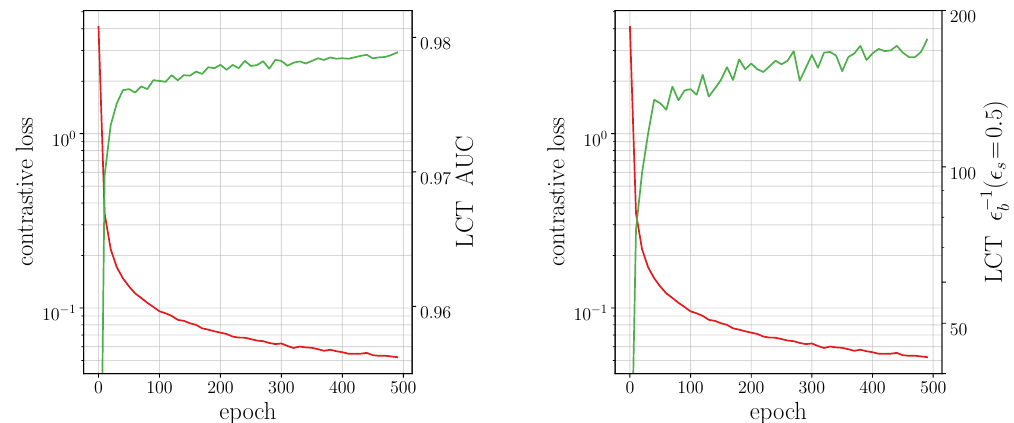
Figure 4: Contrastive loss value and LCT performance on test data as a function of the training epochs. The LCT is performed every 10